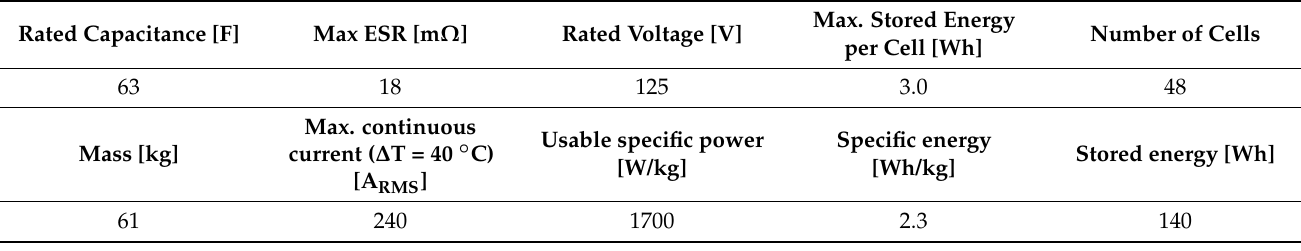
Table 1. Table 2 contains the parameters of the tram TMK 2200_K, manufactured by Kon č ar Elektroindustrija Zagreb and TŽV Gredelj d.o.o., and the parameters of the power grid. Table 1. Parameters of the supercapacitor module 125 V HEAVY TRANSPORTATION MODULE.